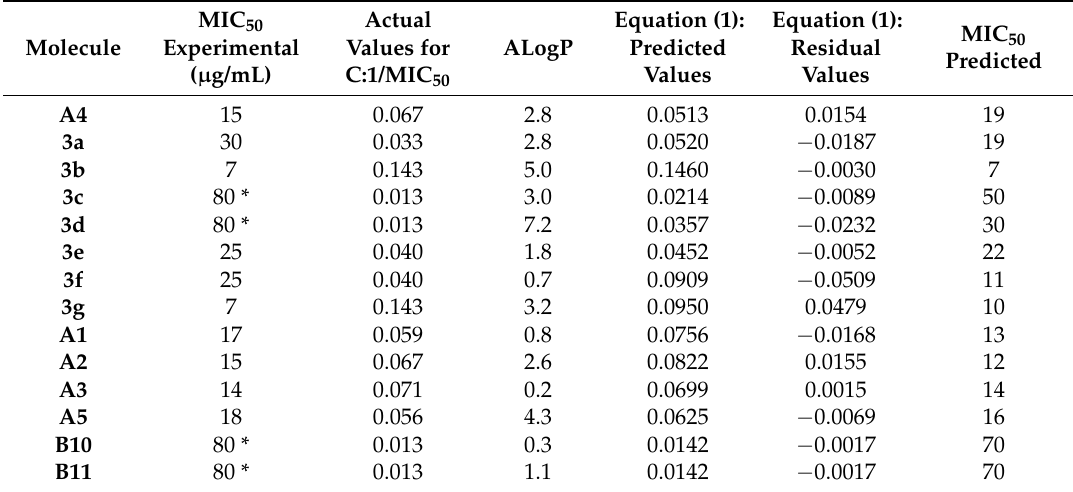
Table 3. Comparison of experimental and calculated antimicrobial activity against S. aureus .